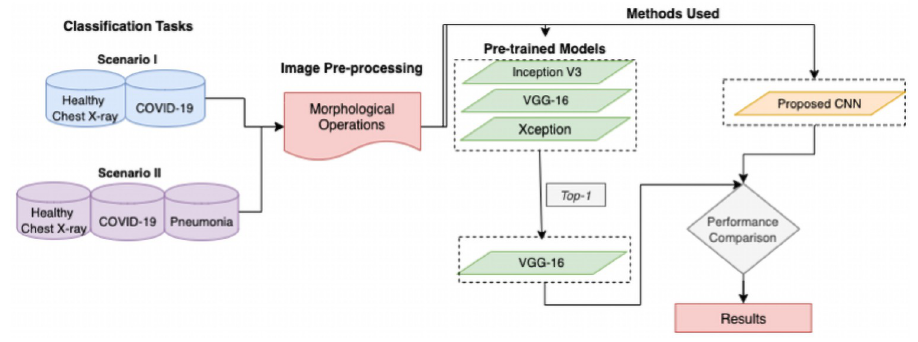
Fig 2. The pipeline